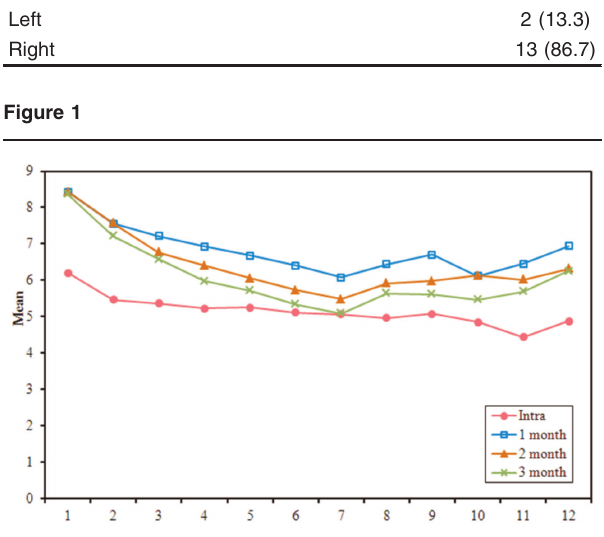
Comparison between impedance in different periods ( n = 15).